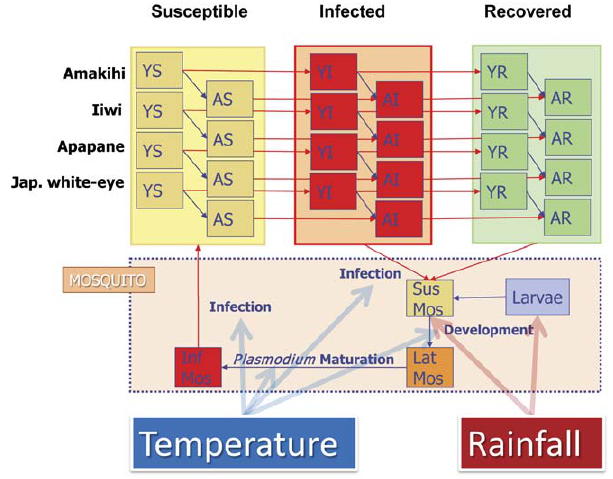
Figure 2. Malaria-forest bird epidemiological model. Mosquitoes develop from Larvae to susceptible adults (Suc Mos). They become infected, but not infectious (Lat Mos) after feeding on acutely infected (YI/AI) or chronically infected (YR/AR) birds. Once malaria parasites mature in a latent mosquito it becomes infectious (Inf Mos) to susceptible (YS/AS) birds. Temperature and rainfall affect the rates of mosquito development (Larvae R Sus Mos), malaria maturation (Lat Mos R Inf Mos), and